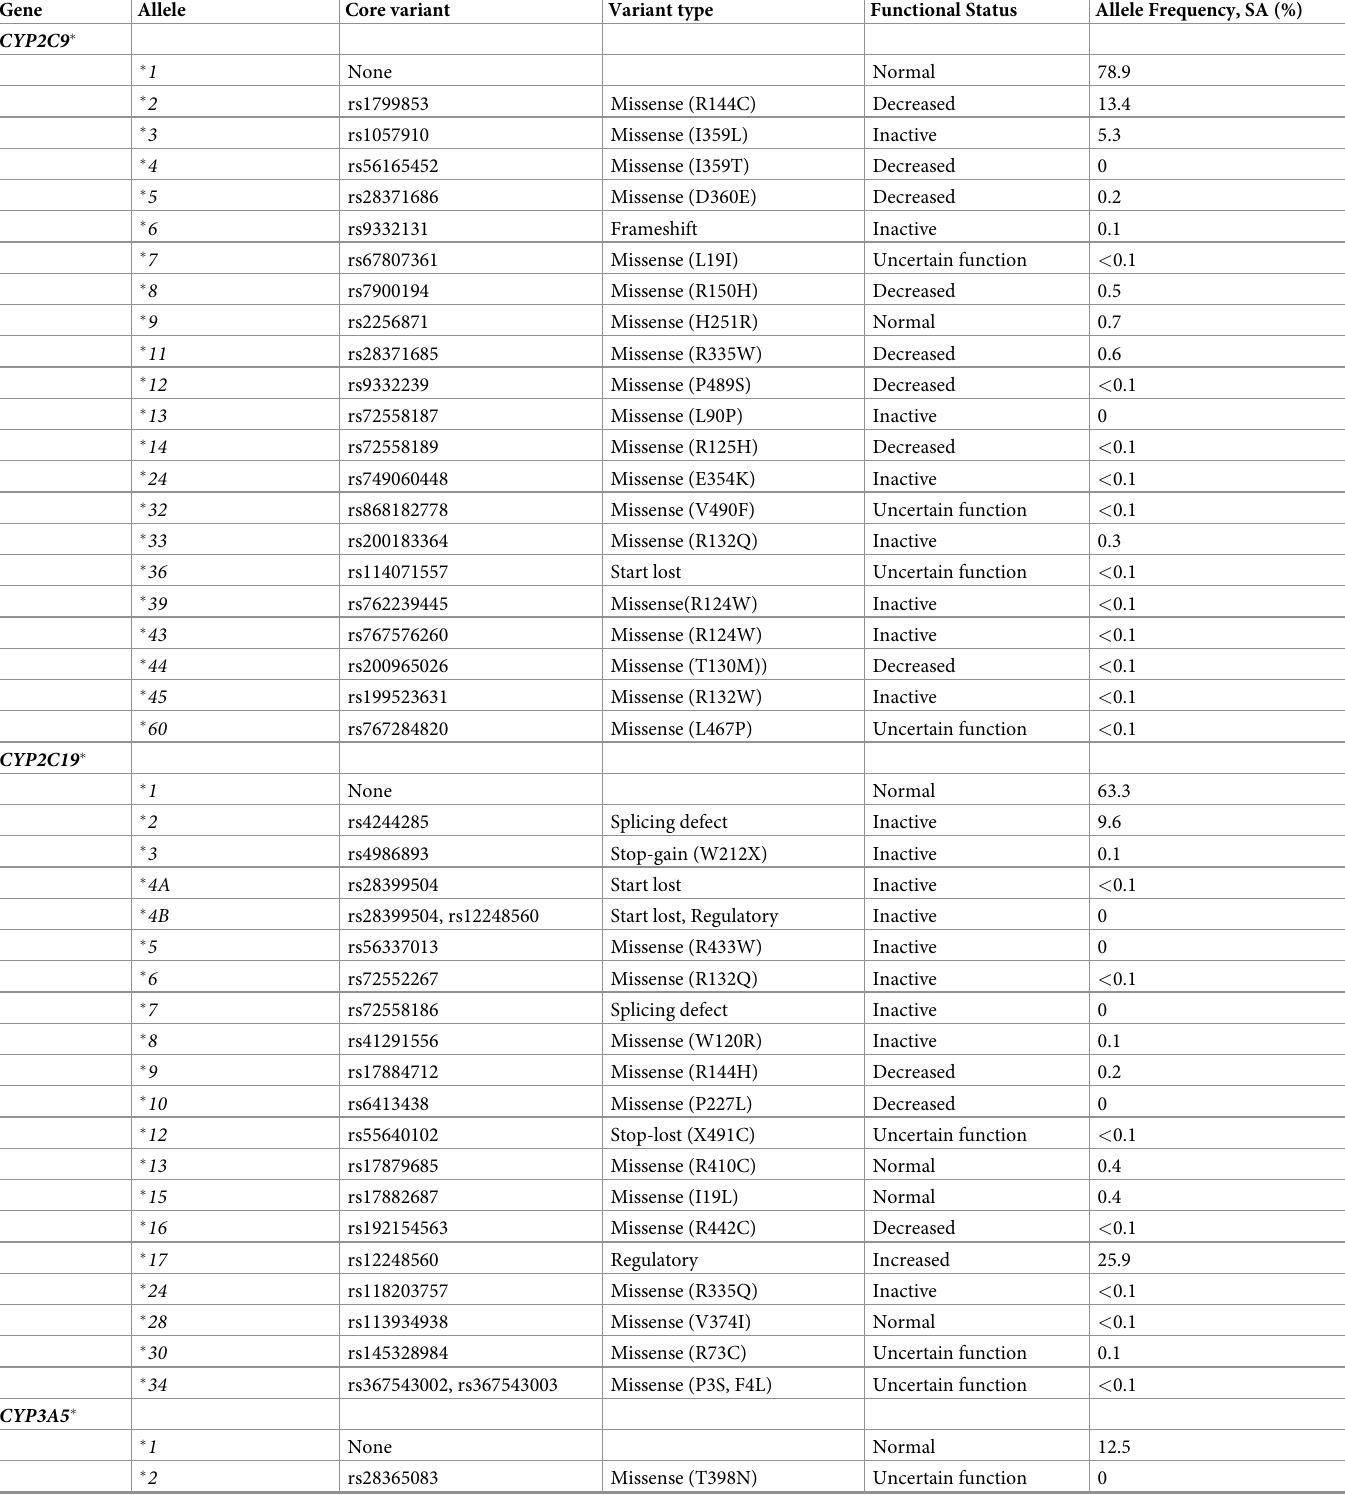
Table 1. Frequencies and functional status of pharmacogenetic alleles in Saudi population.